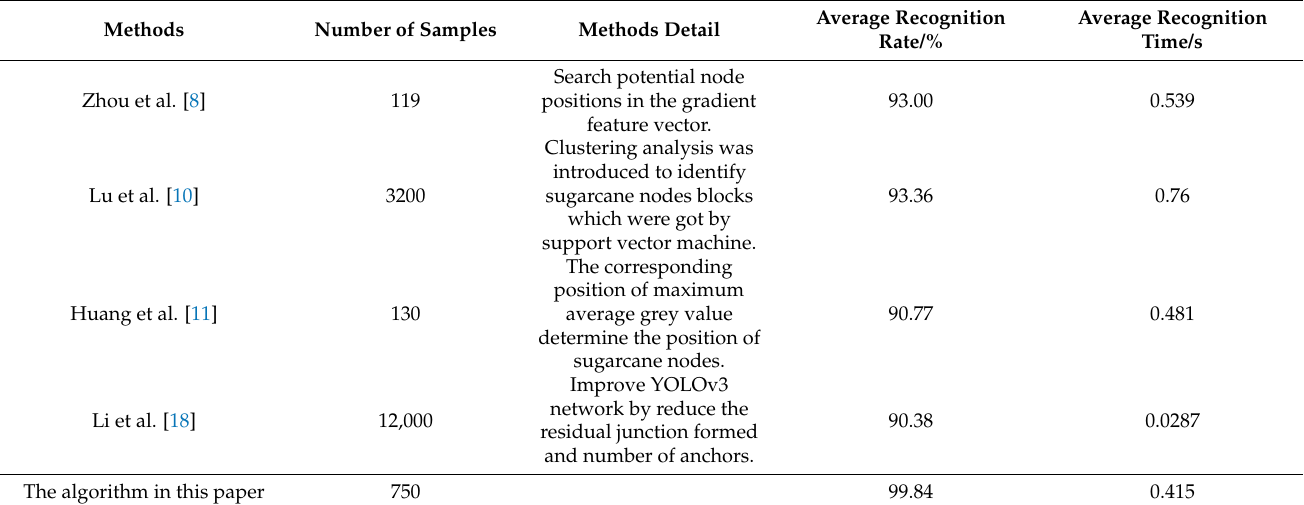
Table 3. Comparison of different recognition